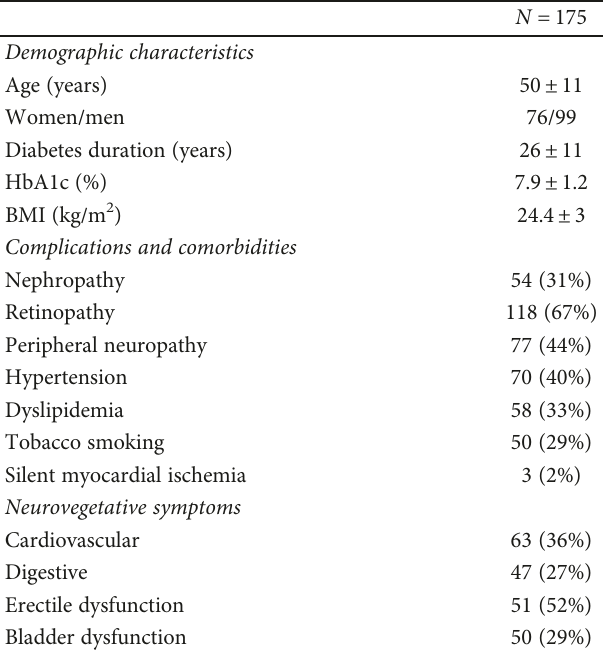
Table 1: Baseline characteristics of the cohort of type 1 diabetic